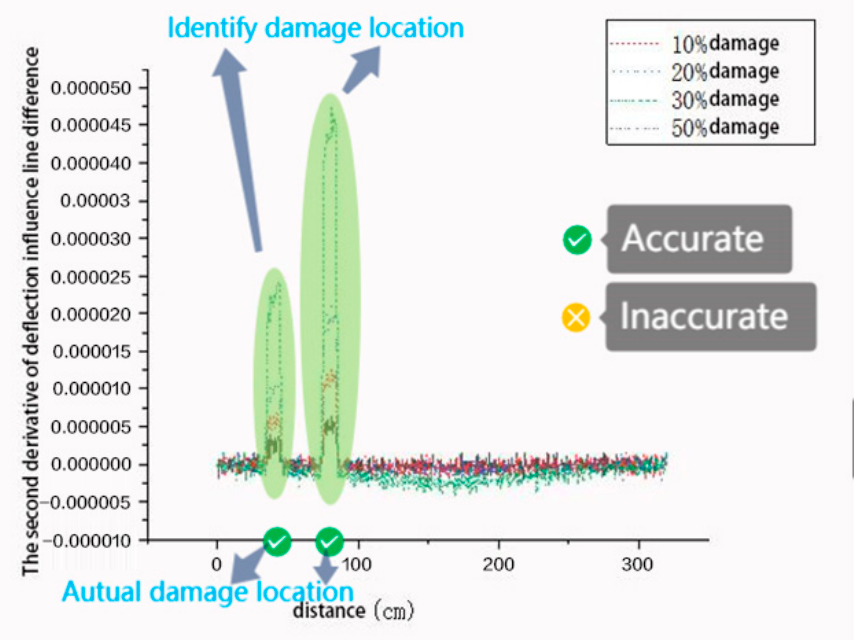
Figure 24. The 2nd derivative of deflection influence line difference at 3/4 determining point of the 1st span following work condition 2 (2-5).